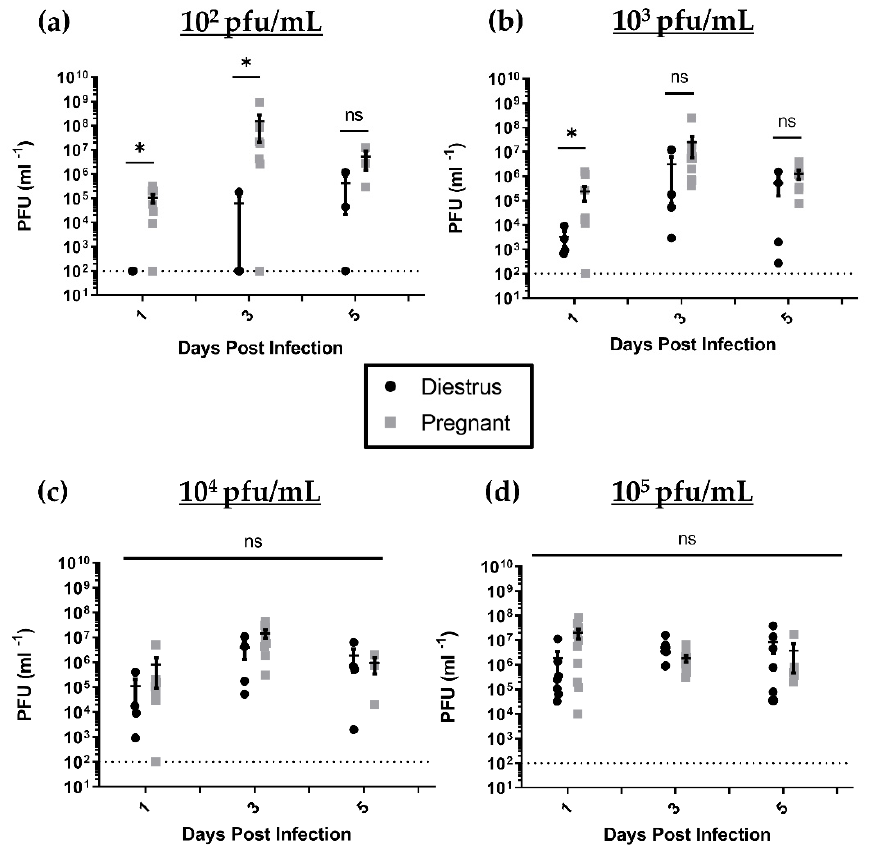
Figure 2. Viral shedding in vaginal washes collected from nonpregnant, diestrus ‐ staged and preg ‐ nant mice at 1, 3 and 5 days post infection (dpi). ( a ) Following intravaginal (IVAG) infection with 10 2 pfu/mL HSV ‐ 2, pregnant mice had increased viral shedding in vaginal washes collected at 1 and 3 dpi compared to diestrus controls. ( b ) At a viral dose of 10 3 pfu/mL, higher rates of viral shedding were observed in pregnant mice compared to diestrus mice 1 dpi, but significant differ ‐ ences were absent at 3 and 5 dpi. In mice infected with high viral doses of ( c ) 10 4 and ( d ) 10 5 pfu/mL, there were no differences in viral titers in vaginal washes collected on any day. Data ex ‐ pressed as mean ± SEM. ns = not significant, * p < 0.05 .